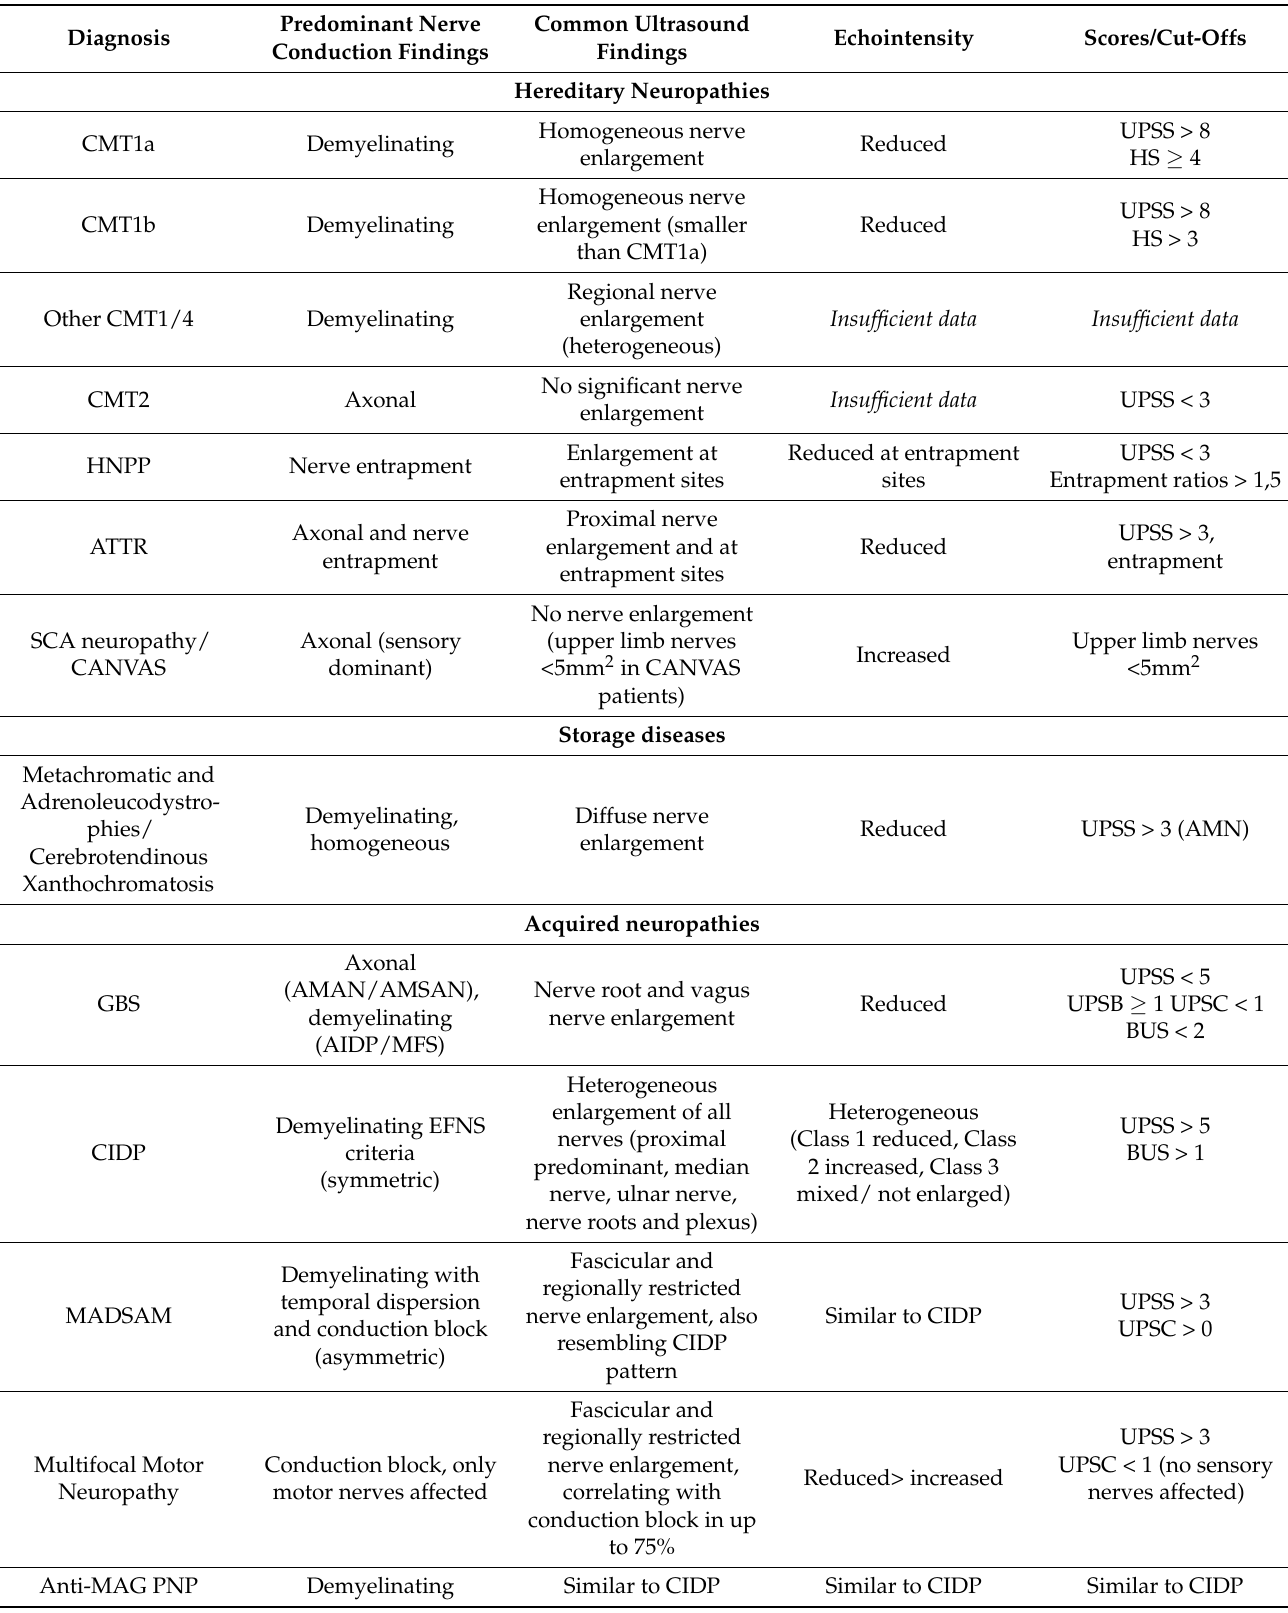
Table 1. Overview of typical nerve conduction and ultrasound findings in various forms of polyneuropathies. A detailed description including references can be found in the text in the respective text